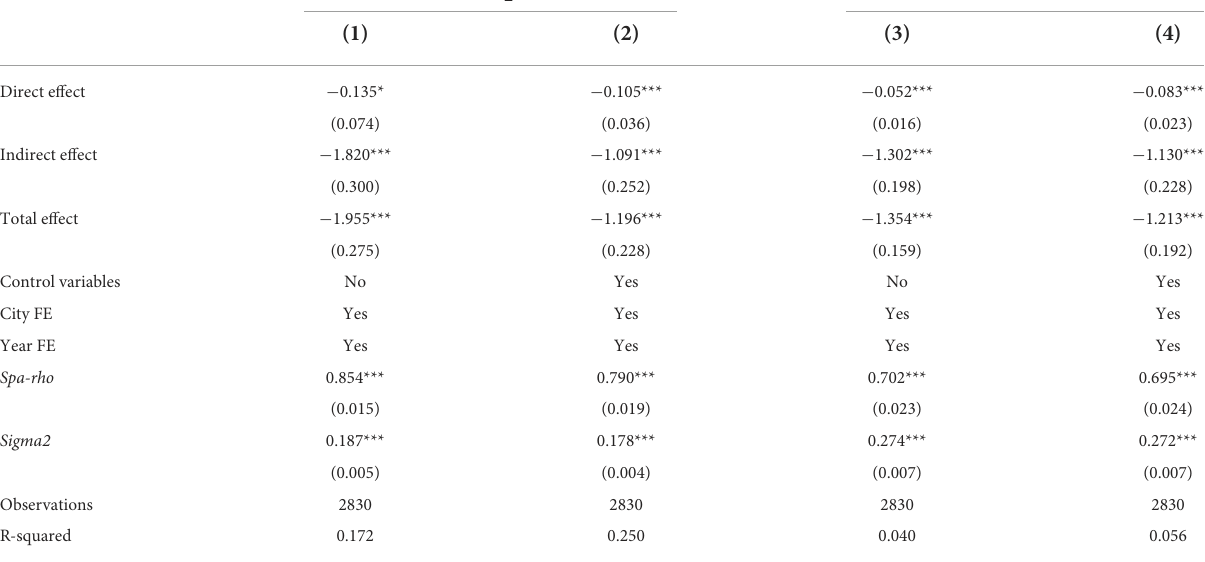
TABLE 9 The results of the spatial difference-in-differences